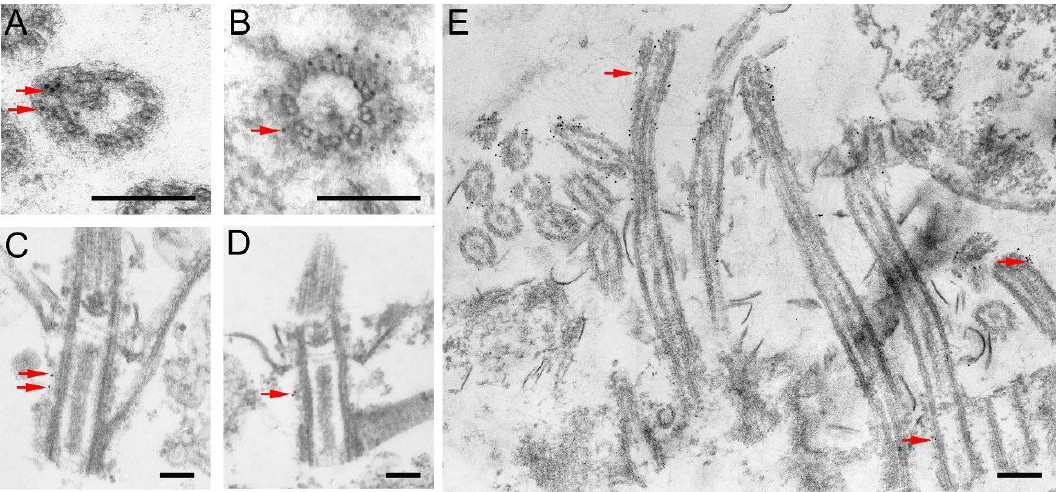
Figure 2. Immunogold TEM localization of Kat2-HA. Kat2-HA localizes near the outer microtubules in the axoneme ( A , E ) and basal bodies ( B – E ), of both somatic ( A – D ) and oral ciliary units ( E ). Cells were preserved either by cryofixation ( A , B ) or by chemical fixation ( C – E ). All ( A , C , D ) or exemplary gold grains ( B , E ) are indicated by red arrows. Overall, 57 and 80 gold grains were found decorating ciliary or basal body microtubules, respectively, in Kat2-HA-overexpressing cells, while only seven and five gold grains were seen near cilia or basal bodies, respectively, in the negative control wild-type cells. In total, 1300 sections of cilia and 317 sections of basal bodies were analyzed in control samples and 500 (80 decorated) and 100 (30 decorated) cilia and basal bodies sections in Kat2-HA-overexpressing cells, respectively. Bar = 200 nm.